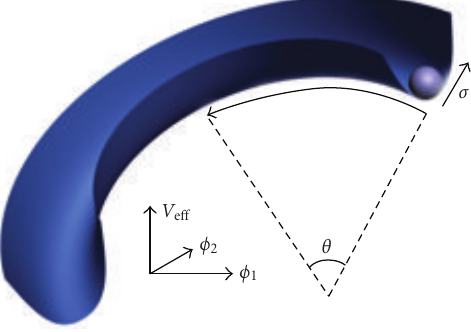
Figure 12: Quasi-single field inflation with turning trajectory. The field θ and σ are in the polar coordinates. The θ is the inflationary direction with a slow-roll potential. The σ is the isocurvature direction, which typically has mass of order H